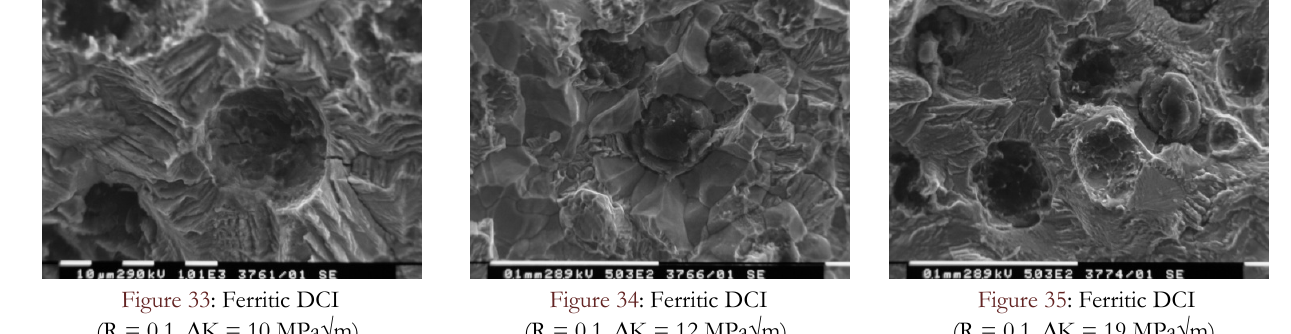
Figure 33: Ferritic DCI (R = 0.1,  K = 10 MPa √ m).